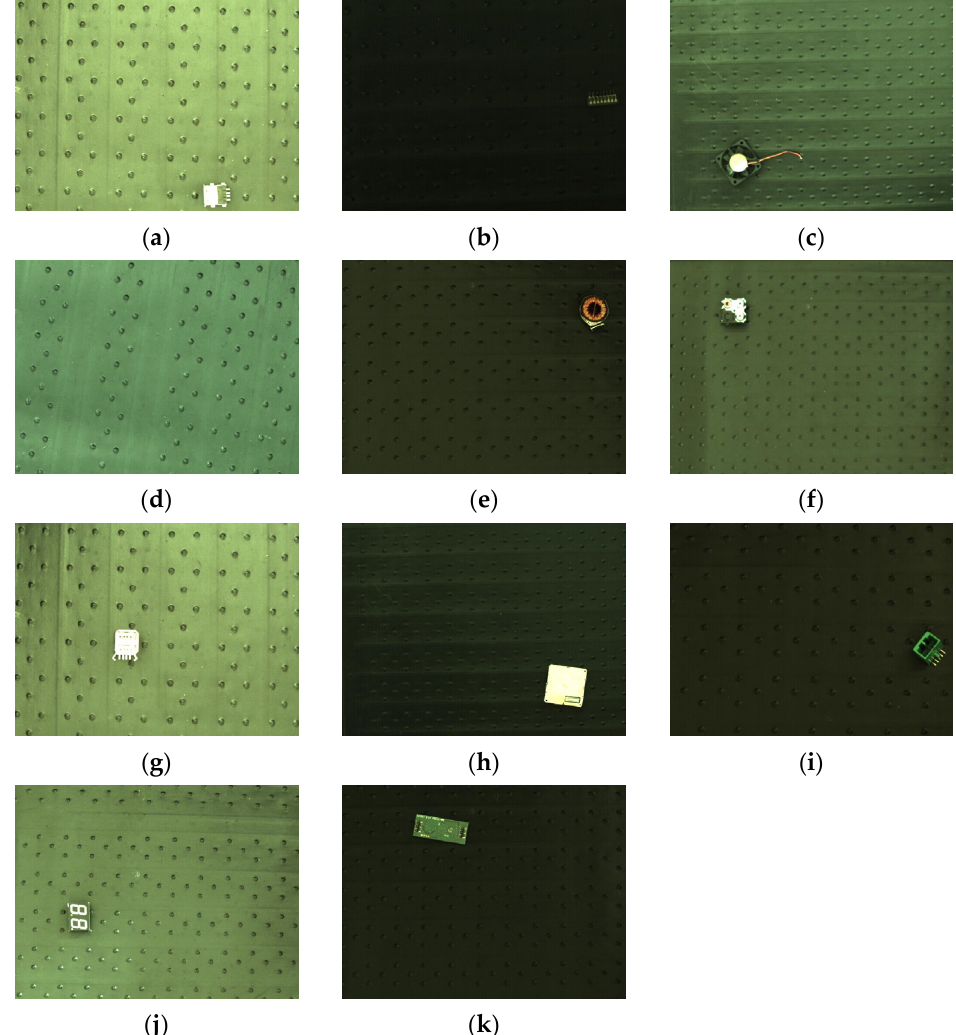
Figure 2. Examples of classified images: ( a ) Class 0 (USB); ( b ) Class 1 (integrated circuit); ( c ) Class 2 (fan); ( d ) Class 3 (background); ( e ) Class 4 (coil); ( f ) Class 5 (AUX); ( g ) Class 6 (USB2); ( h ) Class 7 (communication unit); ( i ) Class 8 (connector); ( j ) Class 9 (display); ( k ) Class 10 (processing